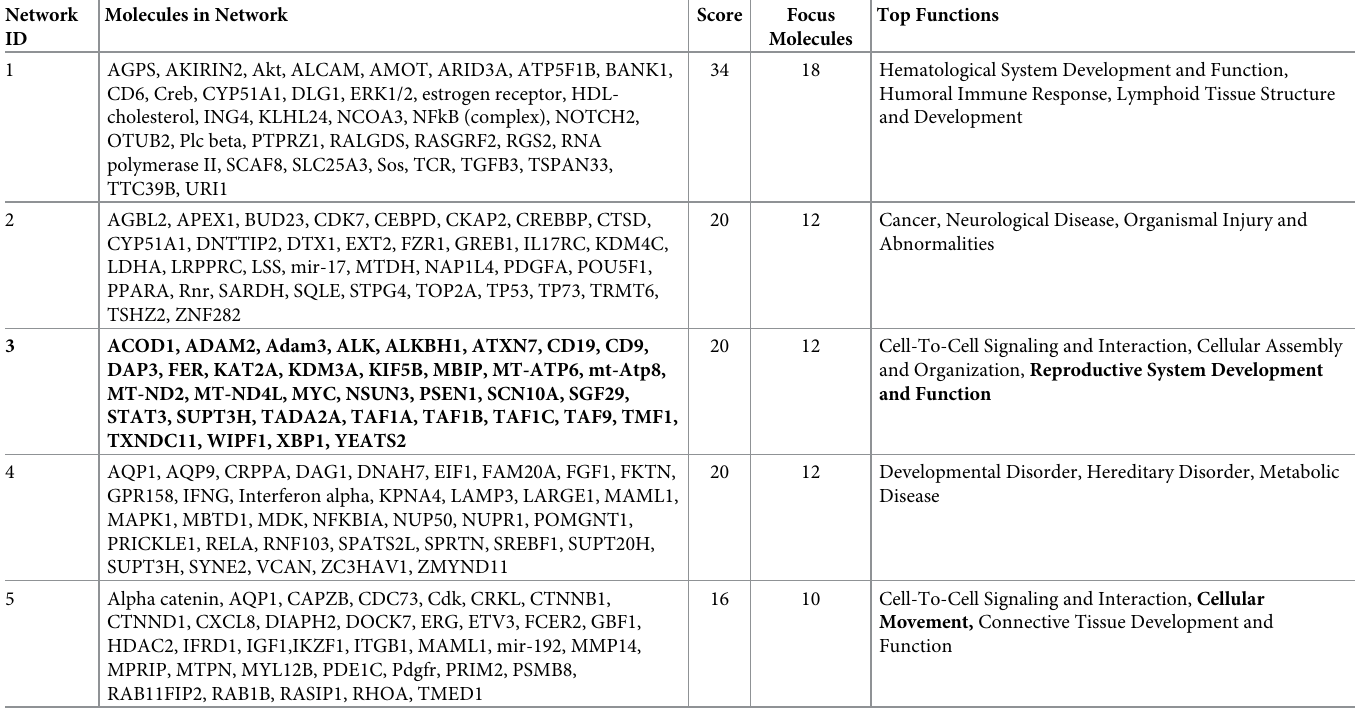
Table 5. Top five networks enriched with differential abundant (DA) genes. Network